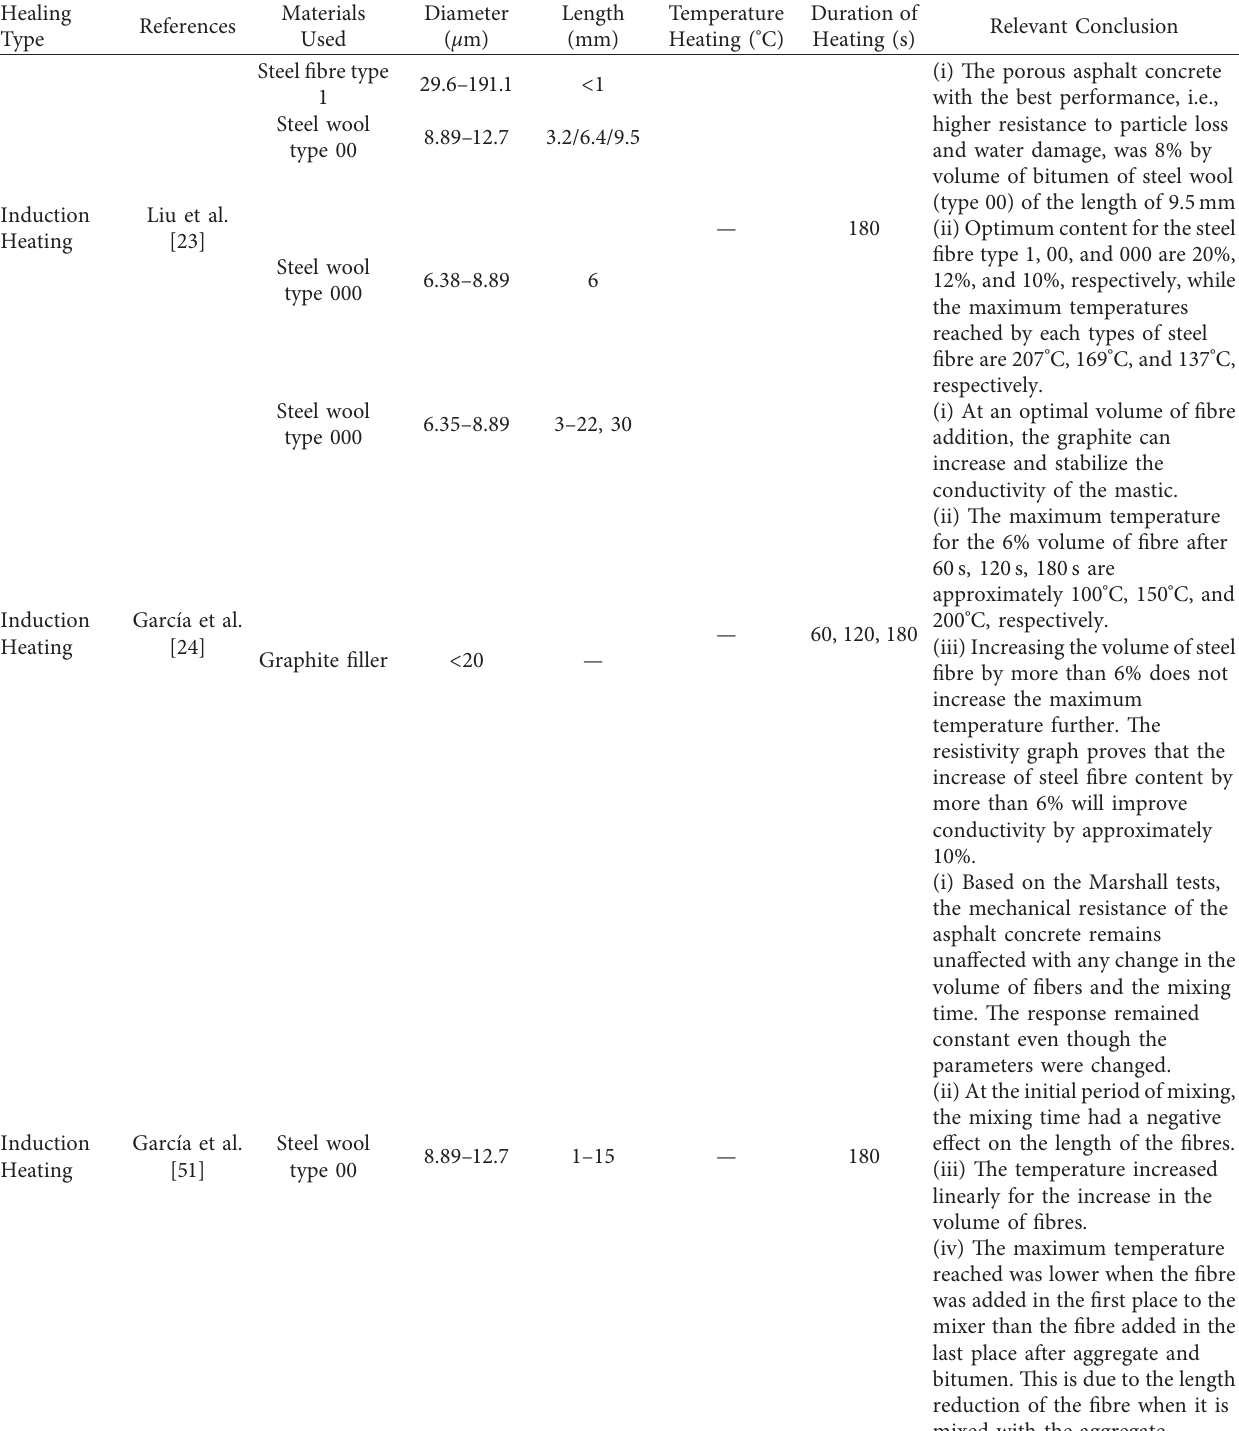
Table 2: List of research studies on the different types of material used for induction healing.